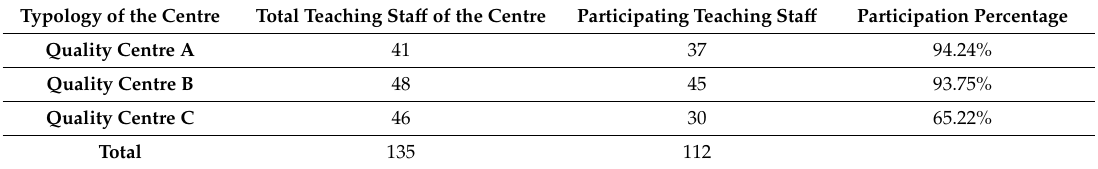
Table 1. Representation of teachers from the population in the